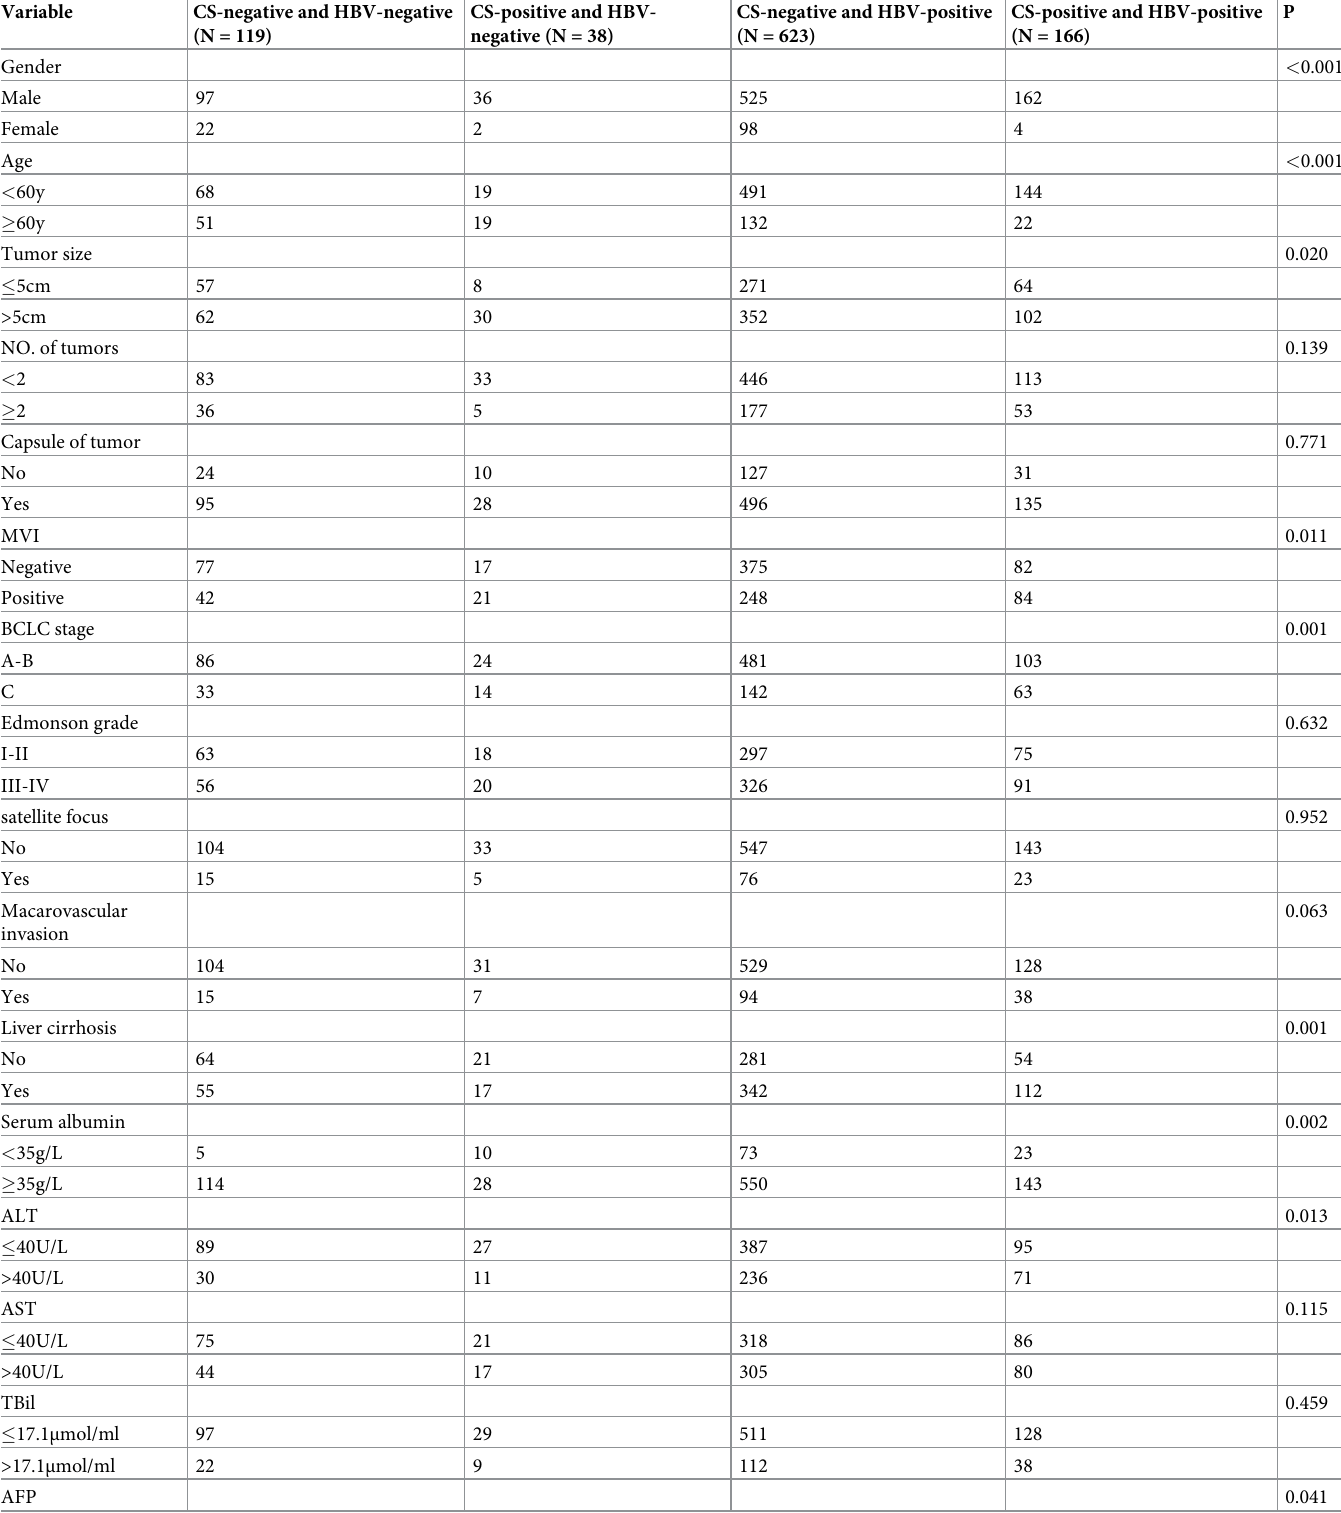
Table 2. Comparison of preoperative clinicopathological data of 4 groups of patients with hepatocellular carcinoma. Variable CS-negative and HBV-negative (N = 119)